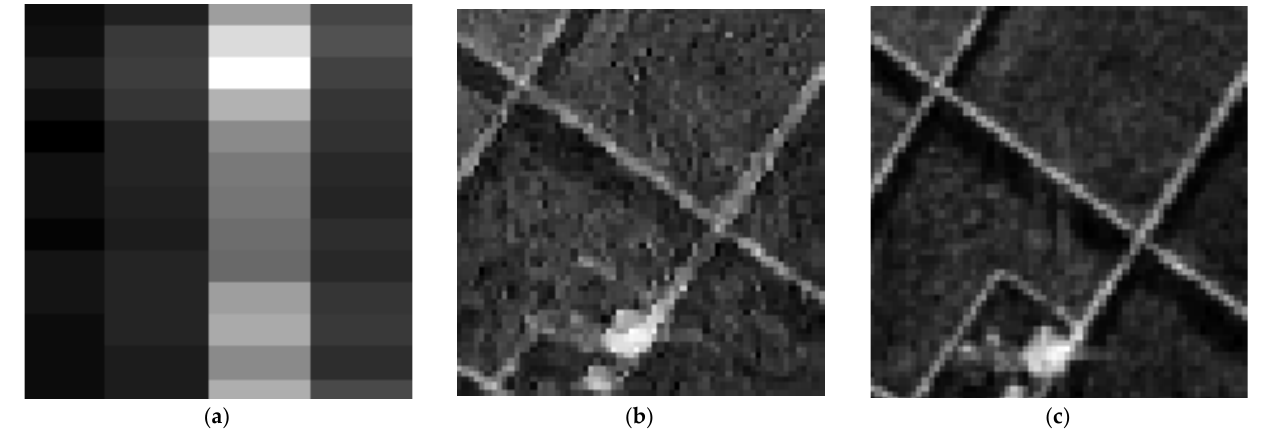
Figure 4. Comparison of the reconstructed results. ( a ) RD image. ( b ) TCS - SAR image. ( c ) Proposed algorithm.